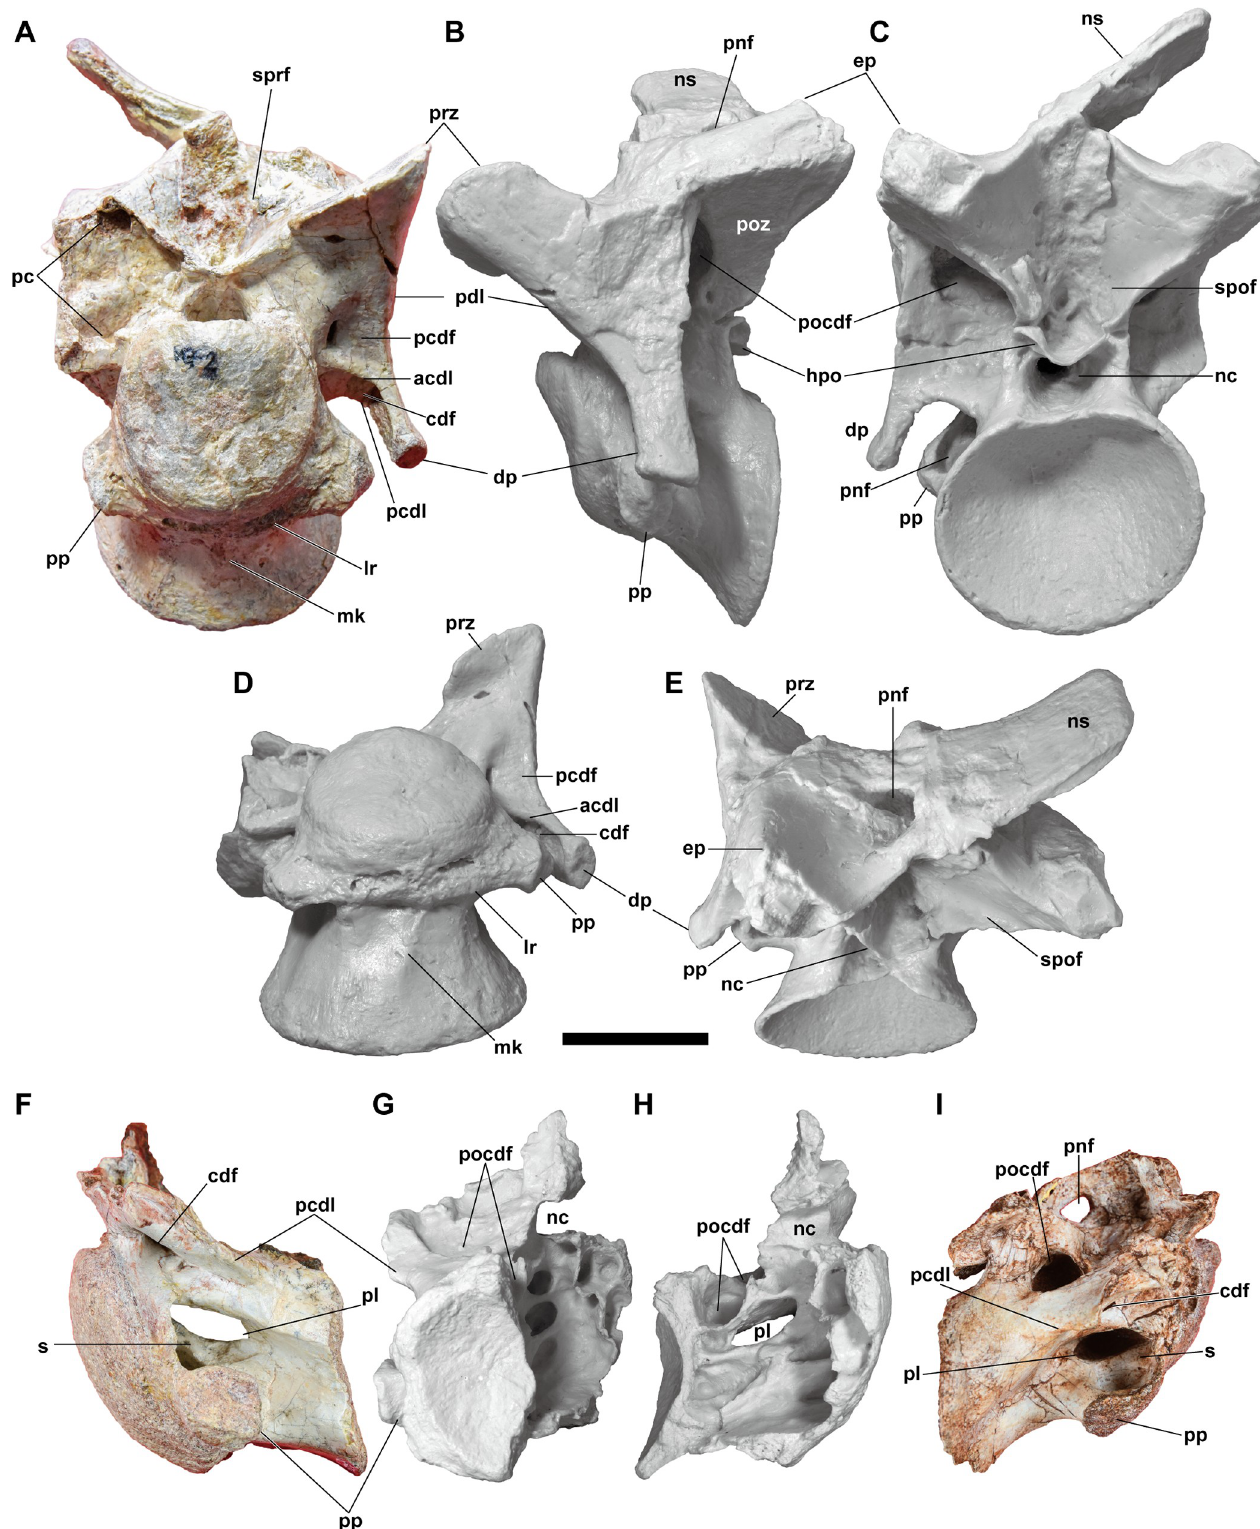
Fig 9. Cervical vertebrae, NRRU-F01020011 (A–E), F01020012 (F–H), and F01020013 (I) in anterior (A), left lateral (B, F), ventral (C), dorsal (D), posterior (C, G), and right lateral (H, I) views. Uncolored casts of each specimen are used for B–E, G and H. Abbreviations: acdl, anterior centrodiapophyseal